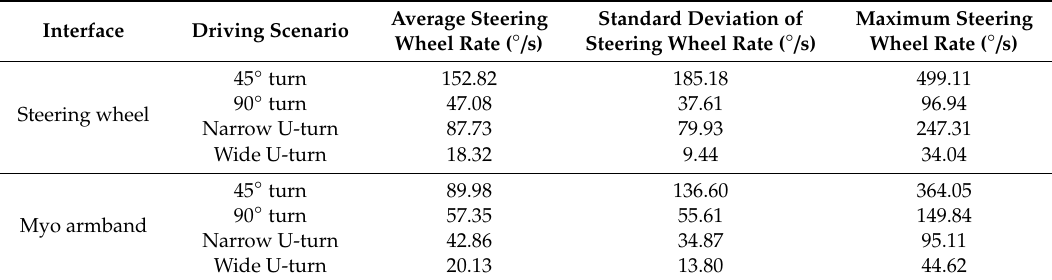
Figure 11. Average steering wheel angle of COMS vehicle for ( a ) 45 ◦ turn, ( b ) 90 ◦ turn, ( c ) narrow U-turn, and ( d ) wide U-turn. Vertical dashed lines indicate average times when drivers exited turns. Table 1. Steering wheel rates of Myo armband and steering wheel